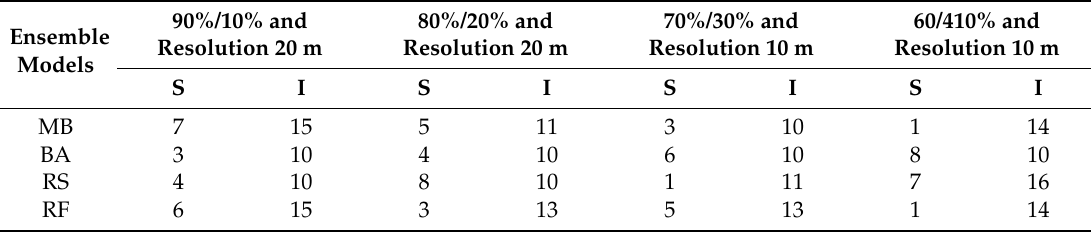
Table 5. The optimal values of the number of iteration and seed for different sample sizes and raster resolutions using ensemble models.